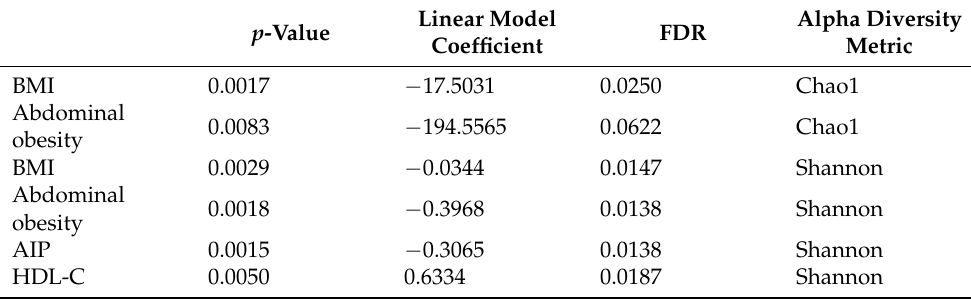
Table 5. Gut microbiota diversity association with clinical parameters.